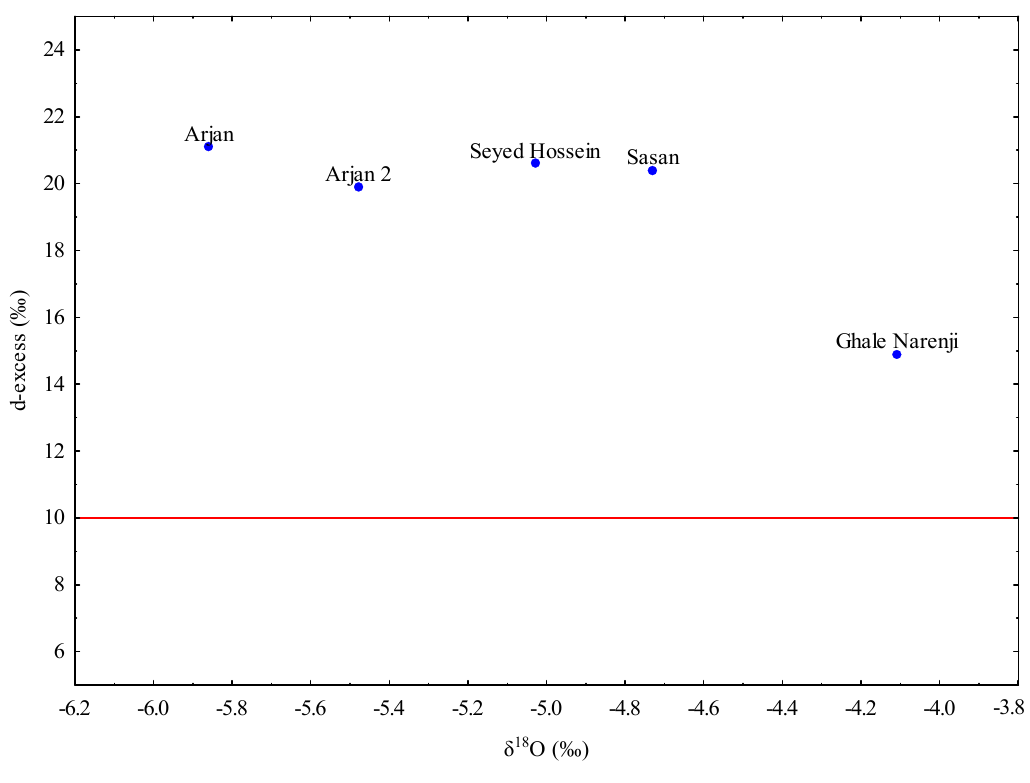
Figure 10. Plot of deuterium excess versus δ 18 O for springs of the studied area. Red line marks the global average d-excess of 10‰ [61].